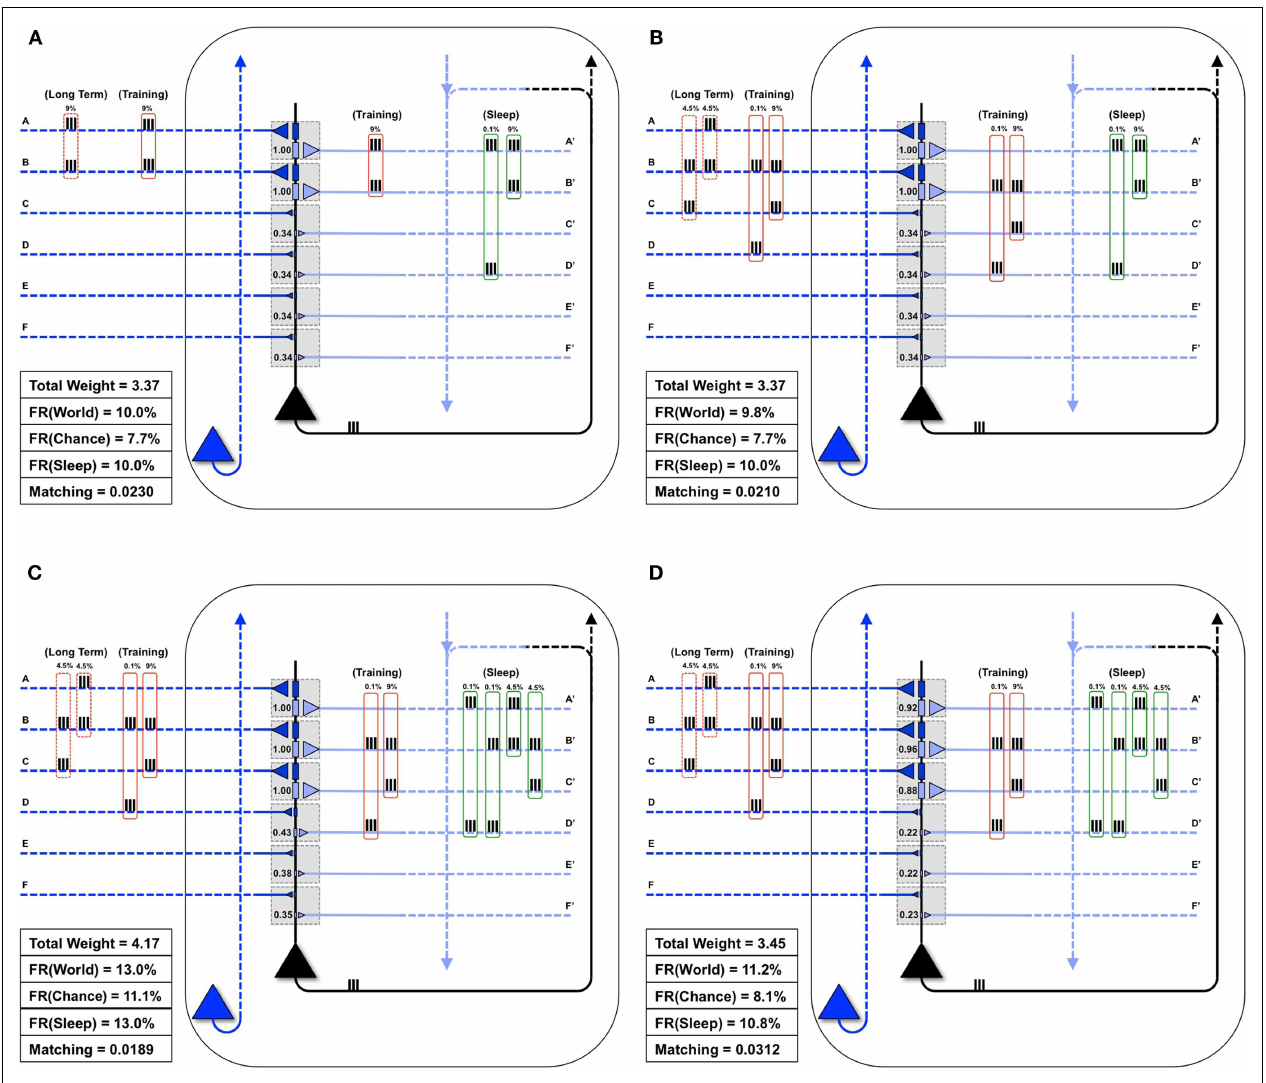
FIGURE 5 | Sleep-dependent synaptic down-selection improves Matching . (A) Initially, the World shows statistical correlation on inputs A and B, and the neuron has appropriately strengthened synapses A/A (cid:48) and B/B (cid:48) . Thus, Matching is high. (B) The Long-Term statistics of the World change such that inputs on A and B, as well as B and C are correlated (as indicated by the dashed red boxes on the left). On this particular Training day, the neuron is exposed to correlated inputs B and C, as well as to a small percent of spurious coincidences on inputs B and D. Before synaptic potentiation occurs, Matching is reduced since the neuron does not yet capture the statistics of the World . (C) During wake, the neuron potentiates synapses C/C (cid:48) ,